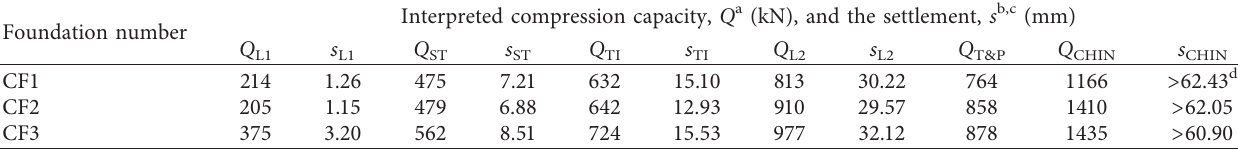
Table 3: Interpreted compression load capacities and settlements for all three foundations.